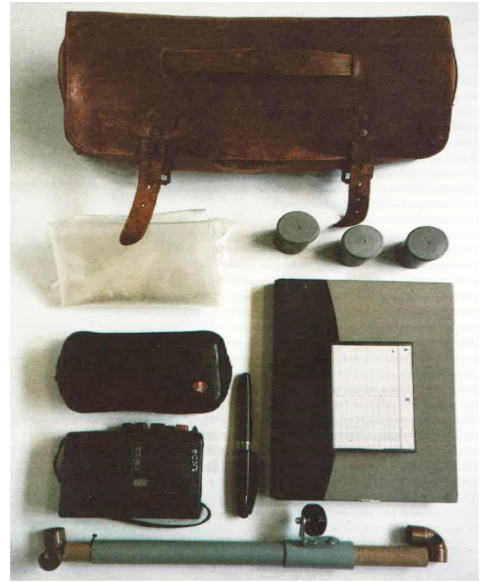
Figure 11. Tools used for fieldwork in the teaching by Anne-Sophie Perrot and in her own research; notebook, camera, films, pen, optical tool to read levels, distances, and